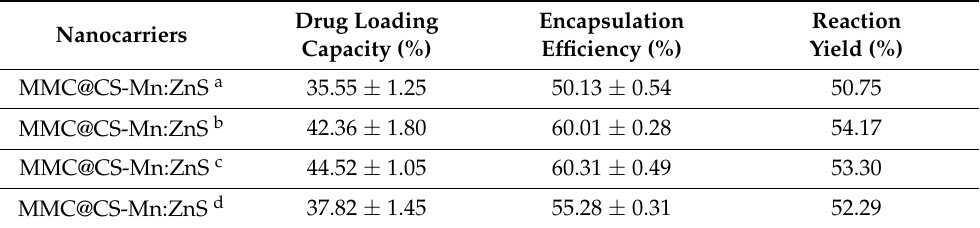
Table 4. Data of DLC, EE, and reaction yield for nanocarriers with different encapsulation with MMC of varying concentration was used. Drug Loading Nanocarriers Capacity (%)